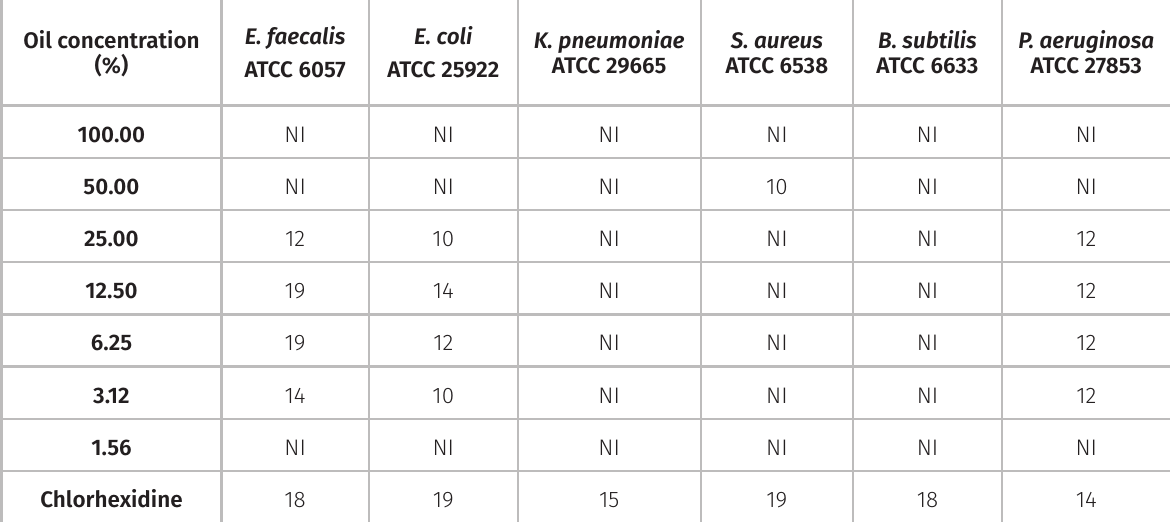
Table I. Inhibition halos of copaiba ( Copaifera multijuga ) natural oil against different bacteria - disc diffusion